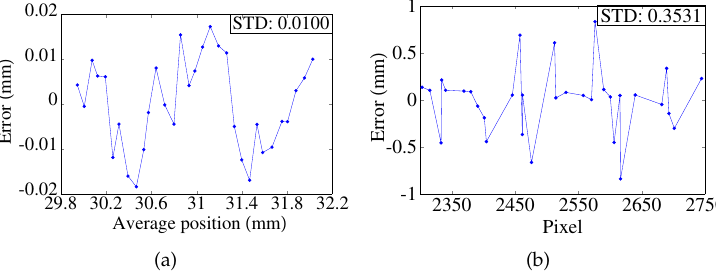
Figure 9. ( a ) Fitting errors with laser beam pointing control; ( b ) Fitting errors without laser beam pointing